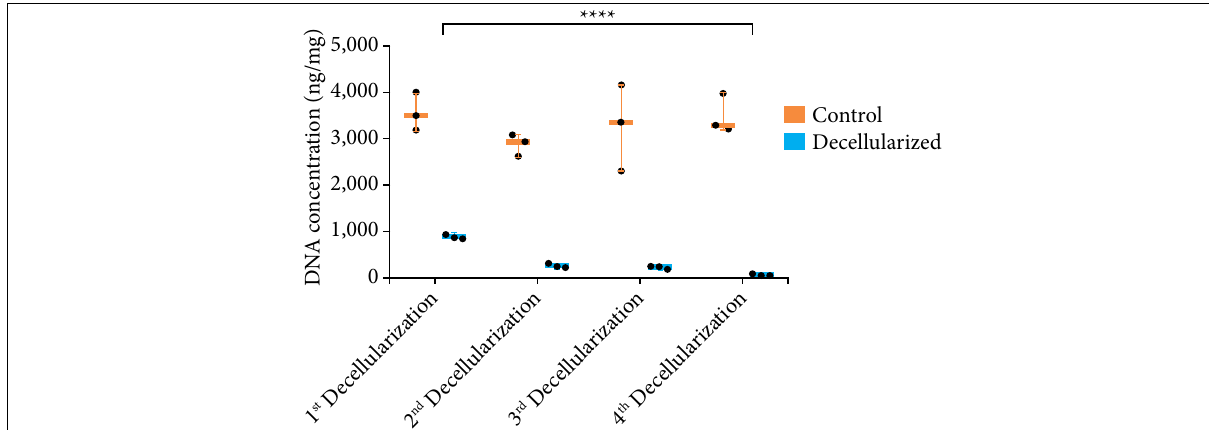
Figure 7 - DNA quantification in decellularized porcine skin. First decellularization: control sample: mean = 3,549.67; decellularized sample: mean = 795.821; p > 0.05. Second decellularization: control sample: mean = 2,872.18, decellularized sample: mean = 223.761; p = 0.0122. Third decellularization: control sample: mean = 3,267.7, decellularized sample: mean = 232.3; p = 0.0126. Fourth decellularization: control sample: mean = 3,491.72, decellularized sample: mean = 41.06; p = 0.0126. P compared between all decellularization: first vs. second decellularization: p = 0.001; first vs. third decellularization: p = 0.0007; first vs. fourth decellularization: p < 0.0001; second vs. third decellularization: p > 0.05; second vs. fourt decellularization: p = 0.0008; third vs. fourth decellularization: p = 0.0014 (n = 5).